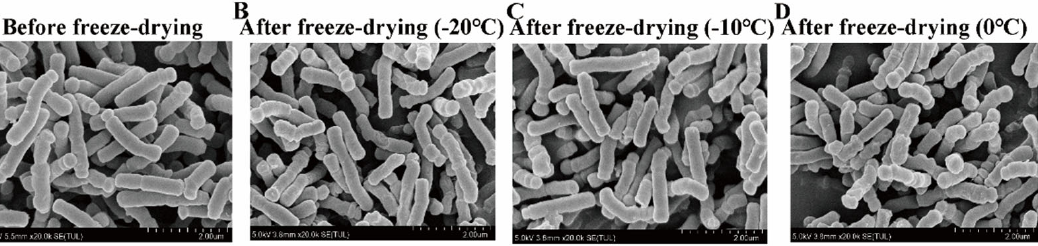
Figure 5. Scanning electron microscope photographs of Bifidobacterium longum BB68S exposed to various sublimation temperatures.